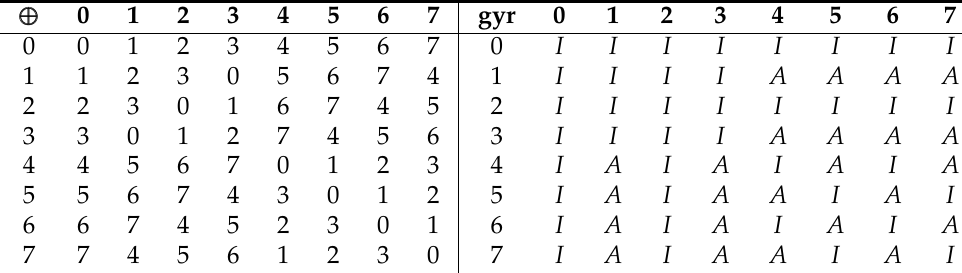
Table 1. The gyroaddition table (left) and the gyration table (right) for the gyrogroup G ( 3 ) . The